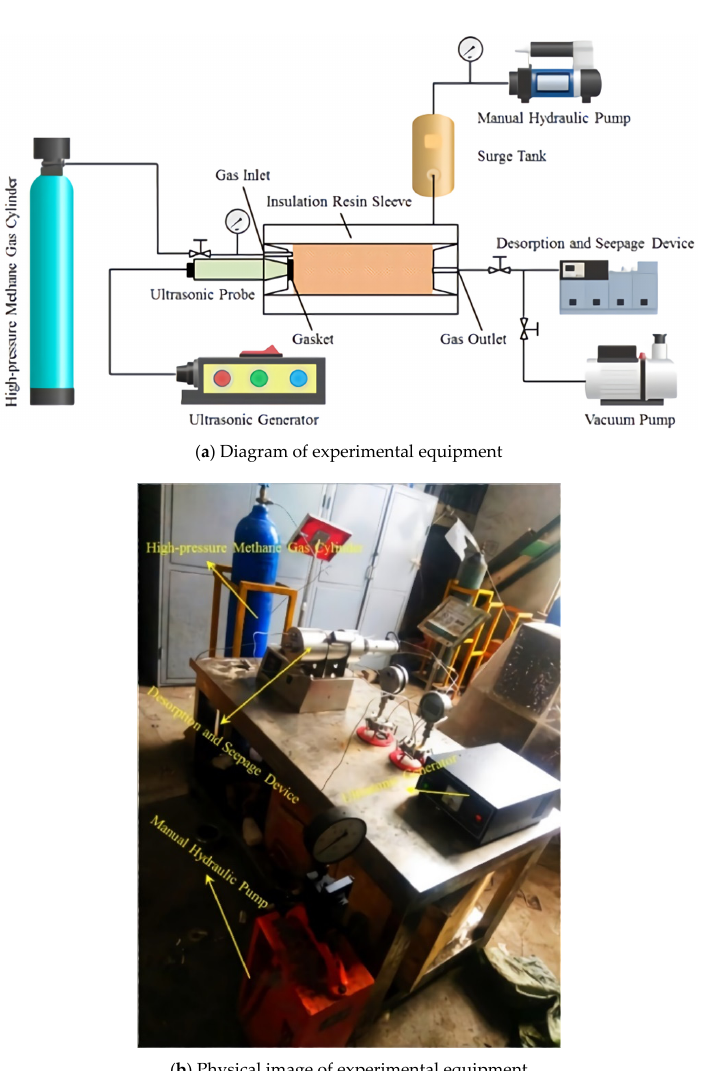
Figure 3. Experimental equipment used for testing CBM seepage under ultrasonic waves